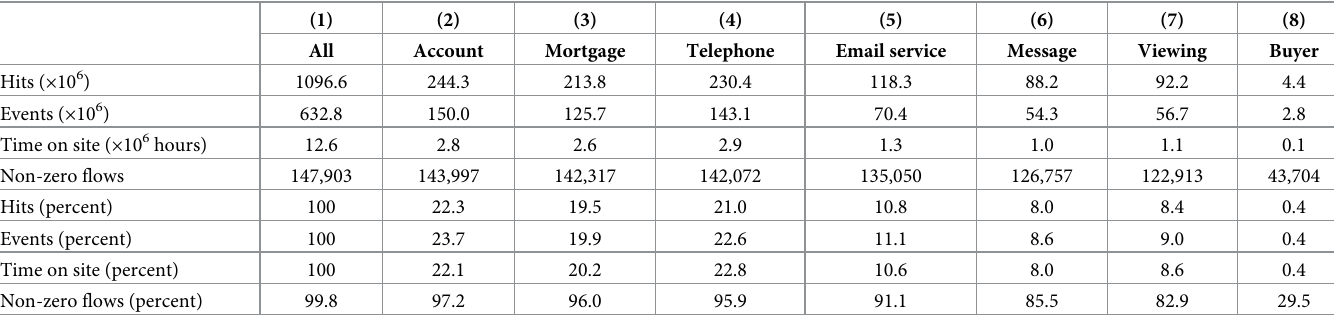
Table 1. Serious searchers (potential house